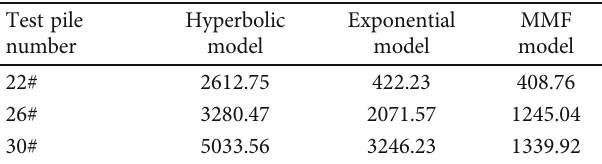
Table 4: The error sum of squares of the results predicted by the three